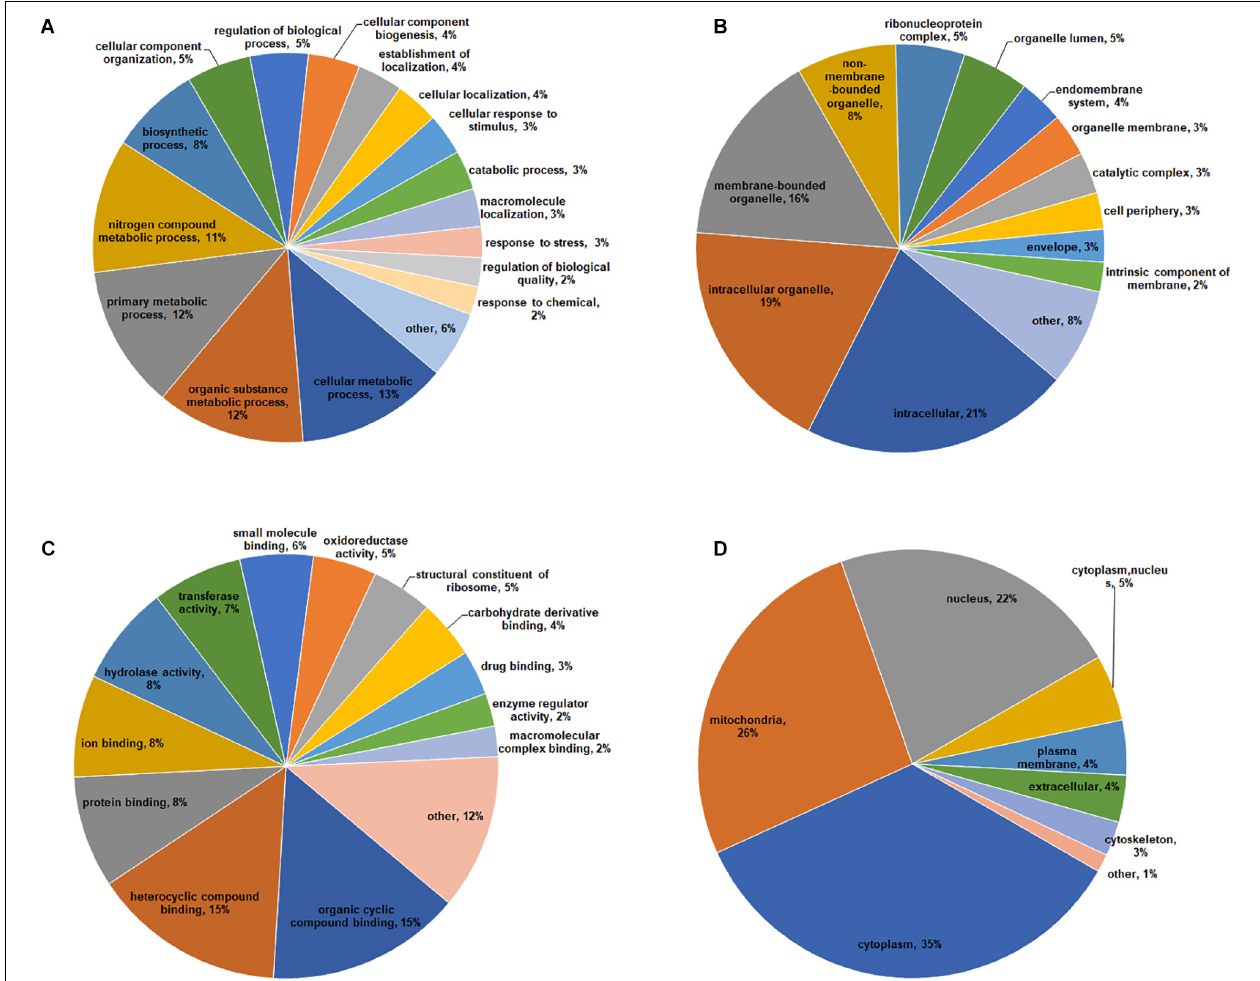
FIGURE 3 | Functional classification of lysine crotonylated proteins based on GO and subcellular location in B. cinerea . GO classification of crotonylated proteins based on biological process (A) , cellular component (B) , and molecular function (C) . (D) Subcellular localization classification of the crotonylated